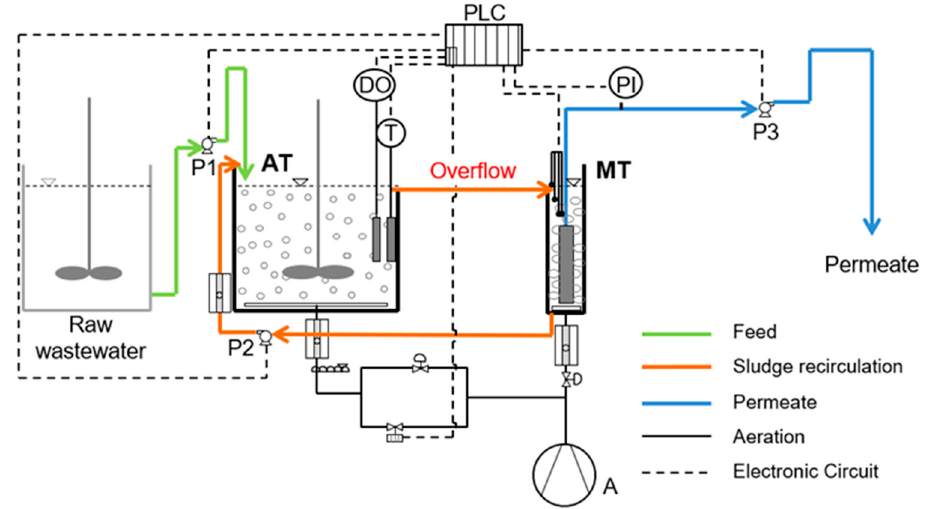
Figure1. Flowdiagramofthemembranebioreactor(MBR)units. AT:aerationtank(20L),MT:membranetank Figure 1. Flow diagram of the membrane bioreactor (MBR) units. AT: aeration tank (20 L), MT: membrane tank (5 L), PLC: programmable logic controller, CO: air compressor, DO: dissolved oxygen controller, PI: pressure indicator, P1: raw wastewater feed pump, Ρ 2: activated sludge recirculation pump, Ρ 3: effluent pump. Table 1. Specifications of the hydrophilic Table 1. Specifications of the hydrophilic membrane.